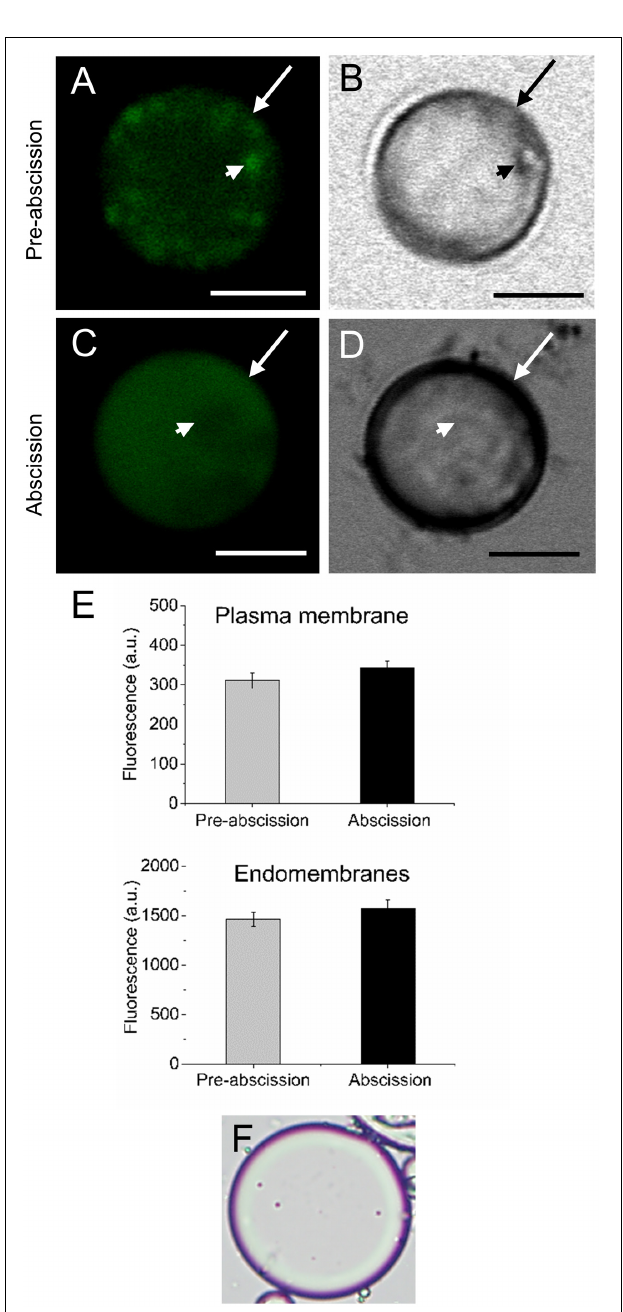
FIGURE 1 | Changes in the lipid amount in live protoplasts from olive AZ during mature-fruit abscission. (A) Bodipy-stained protoplasts from the olive AZ at the pre-abscission stage compared to the white-light image (B) . (C) Bodipy-stained protoplasts from the olive AZ at the abscission stage compared to the white light image (D) . (E) Quantification of Bodipy fluorescence in the plasma membrane (examples marked by arrows) and the intracellular membranes (examples marked by arrowheads) of live protoplasts from olive fruit AZ at different stages during abscission. About 10 protoplasts were acquired for each sample, and data were obtained with FV10 4.2 software (Olympus). (F) Viability was successfully tested using trypan blue. Columns and bars indicate means ± SD, respectively, from five independent experiments. Scale bars are 5 µ m. Arrow: plasma membrane. Arrowhead: